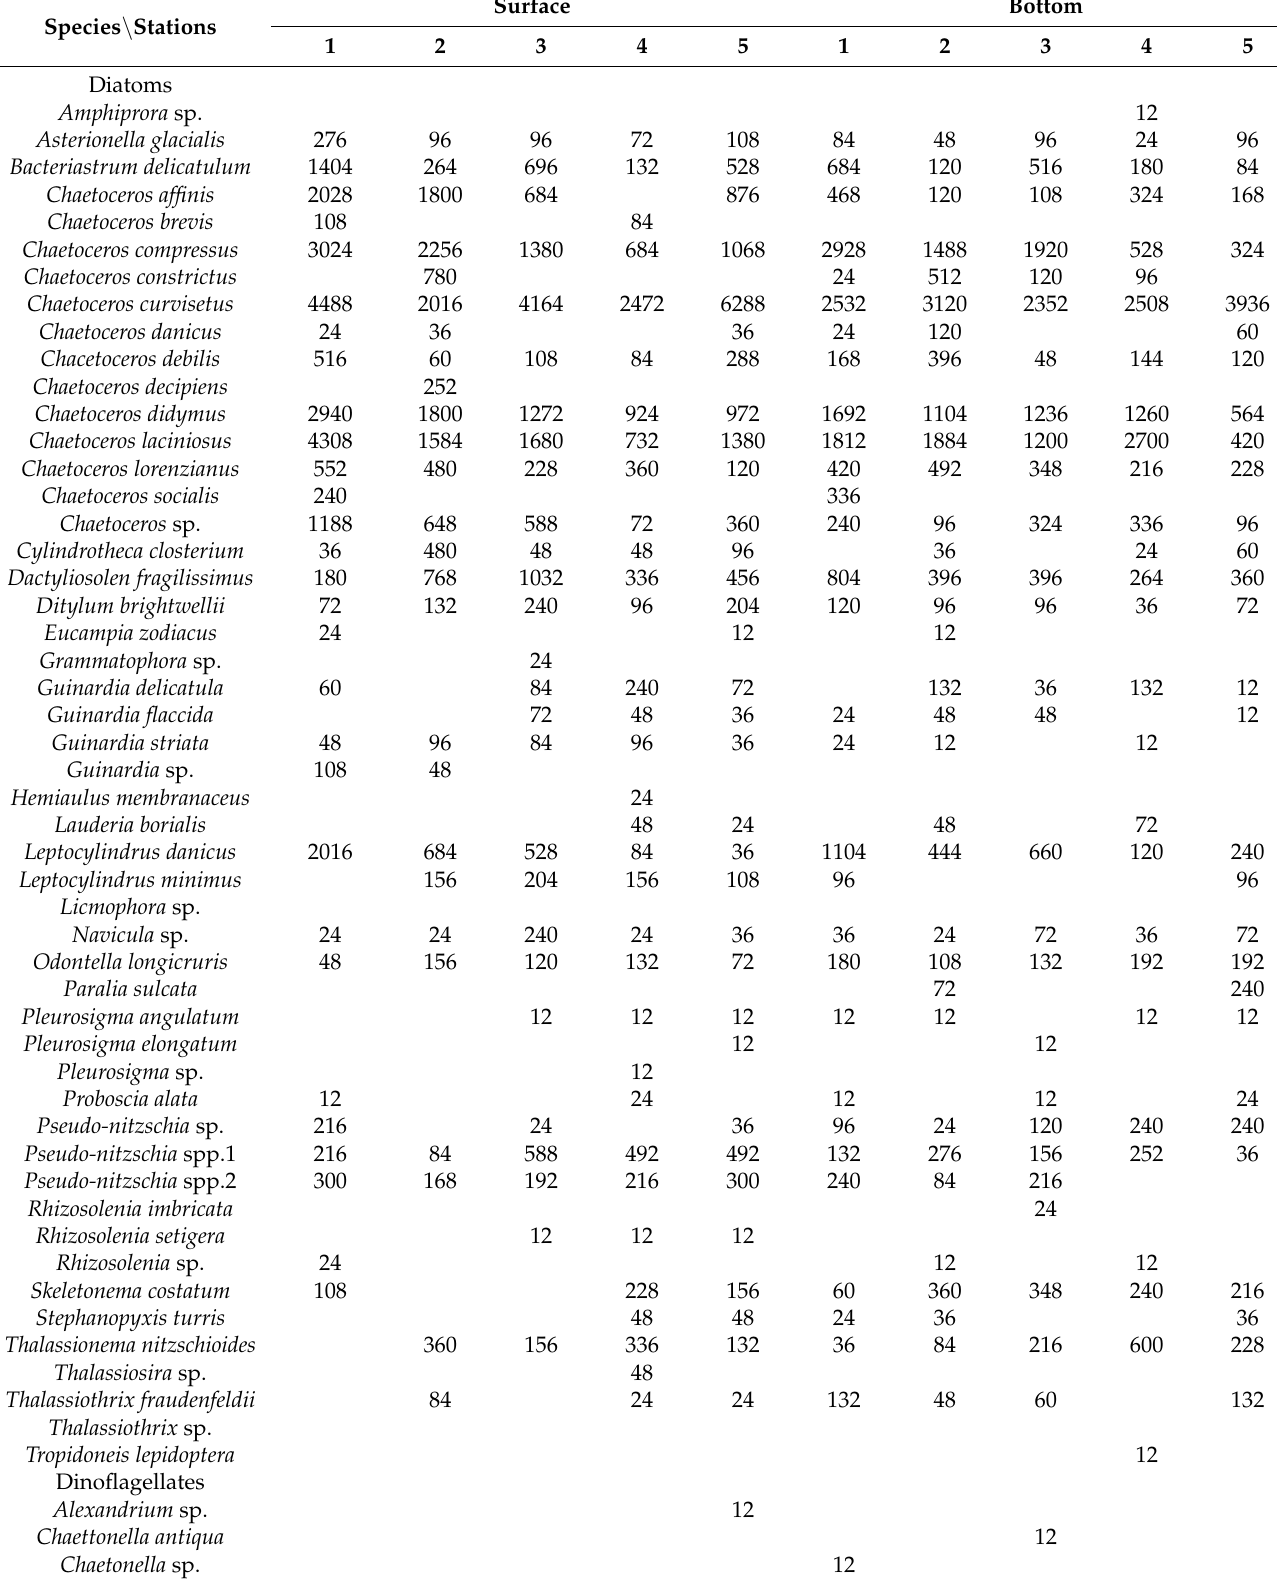
Table 2. Phytoplankton assemblages in the surface and bottom waters in Tongyeong Sanyang-eup in September 2006 ( × 100